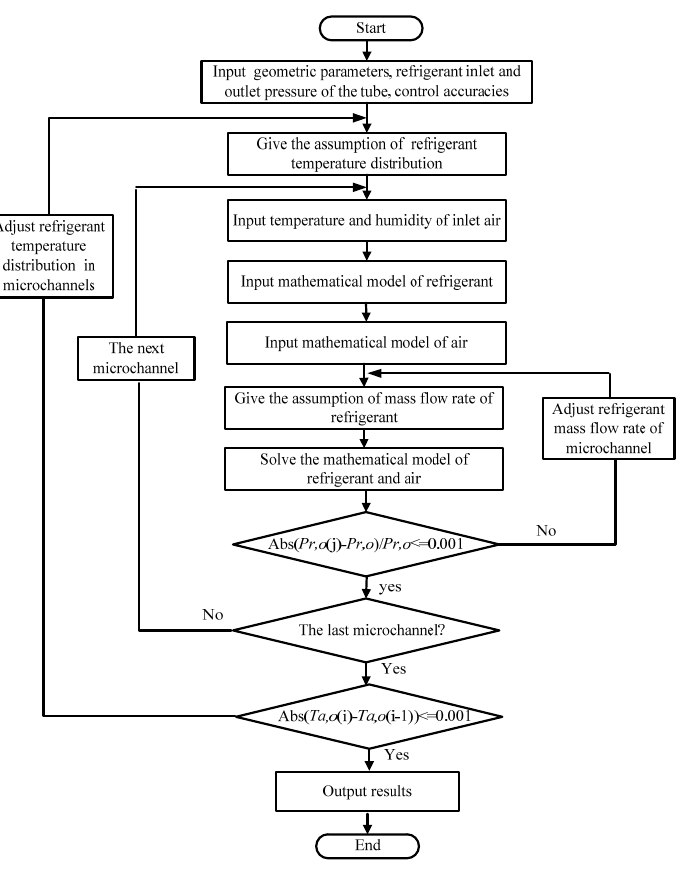
Figure 5. Flowchart of the numerical solution for the mathematical model.